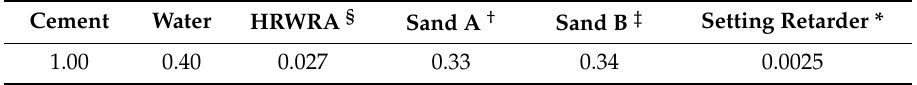
Table 1. Composition of quick-hardening mortar matrix.